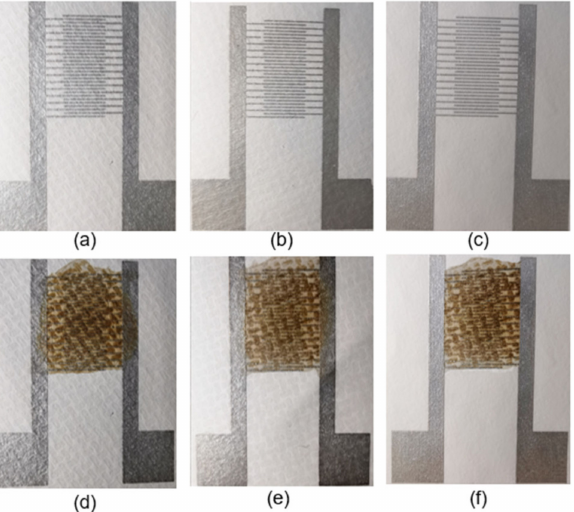
Figure 2. Photographs of the interdigitated electrodes on different substrates: ( a ) bare hydrophobic PTFE, ( b ) ethanol-treated hydrophobic PTFE, ( c ) hydrophilic PTFE. GO on the interdigitated elec- trodes: ( d ) bare hydrophobic PTFE, ( e ) ethanol-treated hydrophobic PTFE, and ( f ) hydrophilic